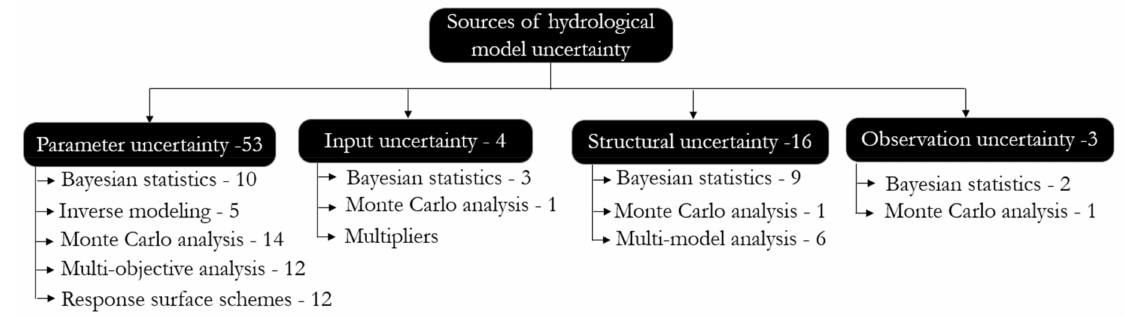
Figure 2. Summary of sources of hydrological model uncertainty and broad techniques used to deal with them. The numbers next to the methods indicates the papers reviewed in Section